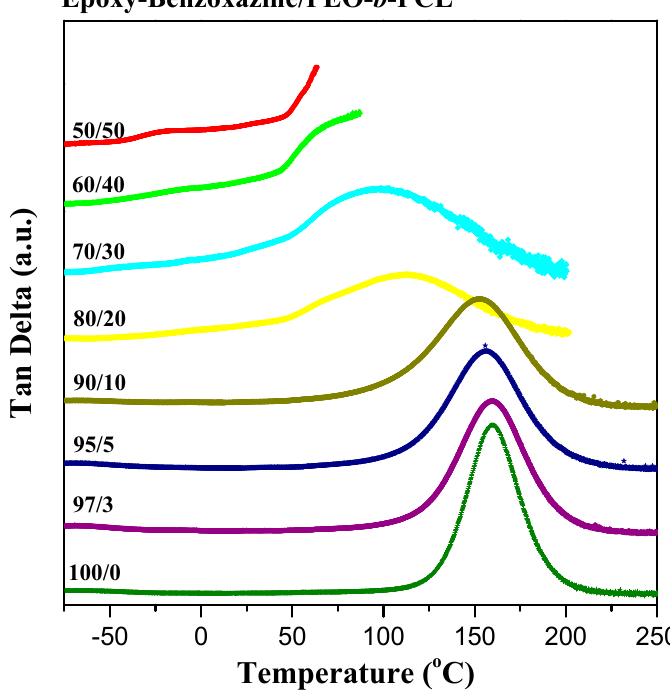
Figure 6. DMA tan δ –temperature curve of epoxy–benzoxazine/PEO ‐ b ‐ PCL blends (heating rate: 2 °C ∙ min –1 ).